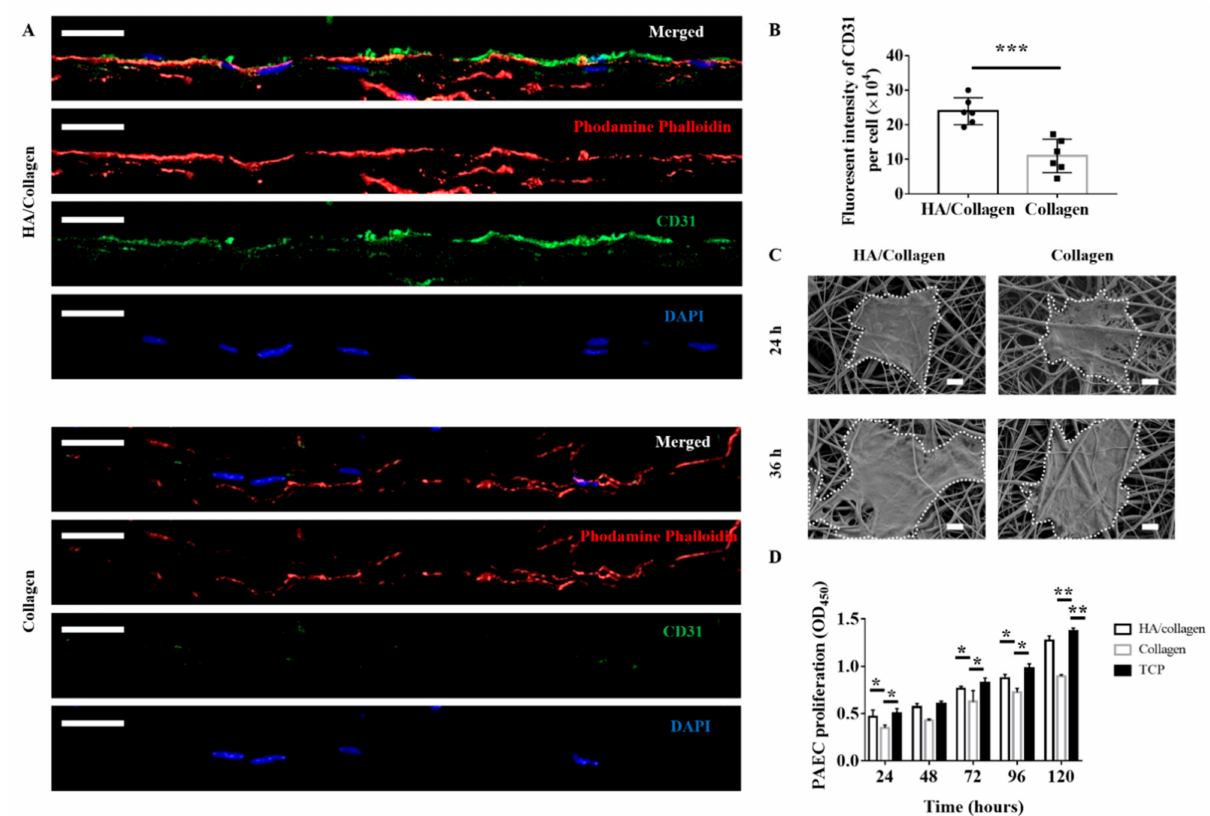
Figure 6. In vitro phenotypic shape and proliferation analysis of mouse PAECs on different substrates. Representative CLSM micrograph cross-section ( A ) of PAECs on different nanofibers after 72 h seeding. Nucleus (blue), cytoskeleton (red), CD31 (green). Scale bars: 20 µ m. Statistical data of CD31 fluorescence ( B ) in ECs after 72 h seeding ( n = 5). *** p < 0.001. Representative SEM micrographs ( C ) of PAECs on different nanofibers after 24 and 36 h seeding. Scale bars: 5 µ m. The proliferation ( D ) of PAECs on different nanofibers and TCP (positive control) during a period of 5 days ( n = 3). * p < 0.5; ** p <